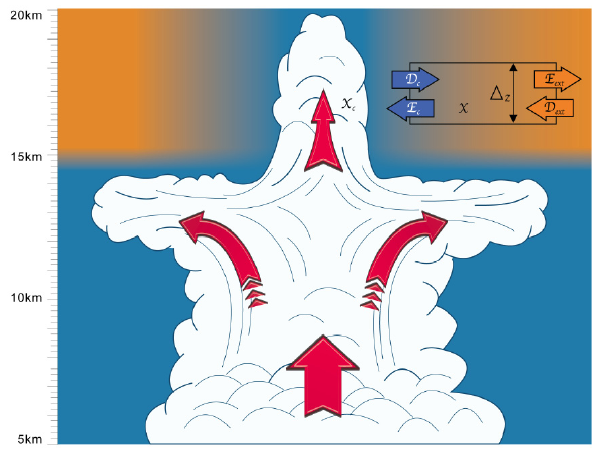
Fig. 8. Schematic of the TTL aerosol-cleansing model by over- shooting